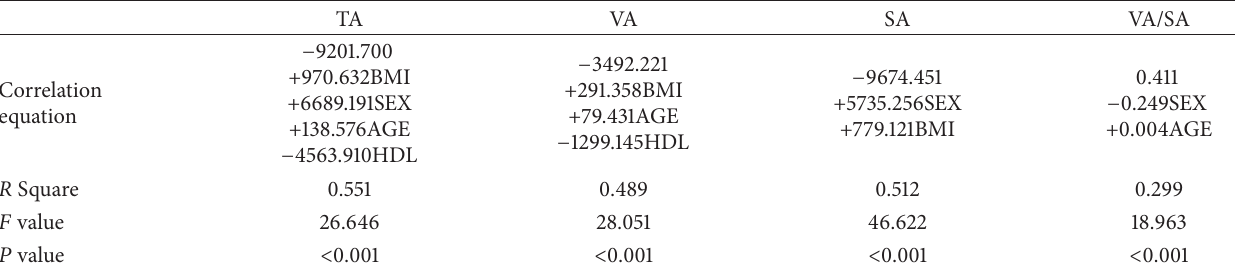
Table 2: Correlation of abdominal fat in patients with type 1